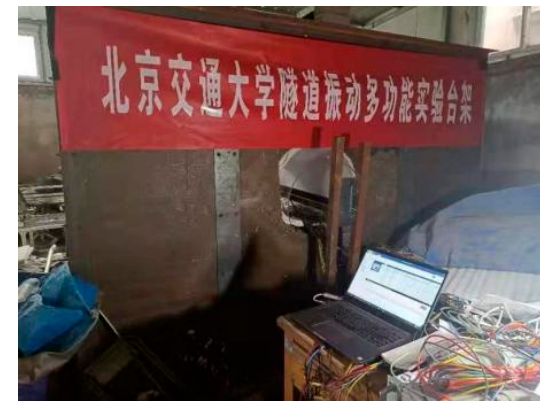
Figure 6. Model test bench.